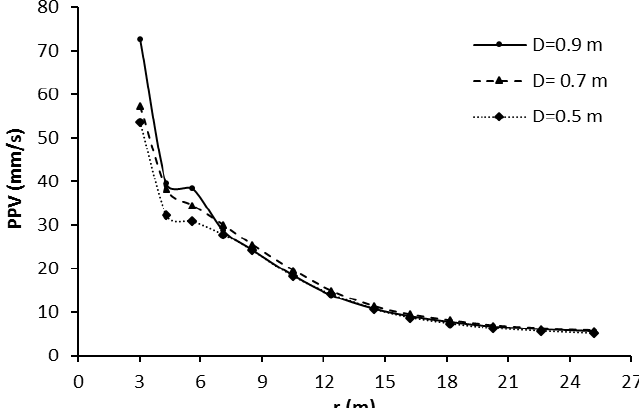
Fig. 10. Variation of PPV values on the ground surface with radial distance from pile axis for different pile diameters and the impact force of 3.2 MN